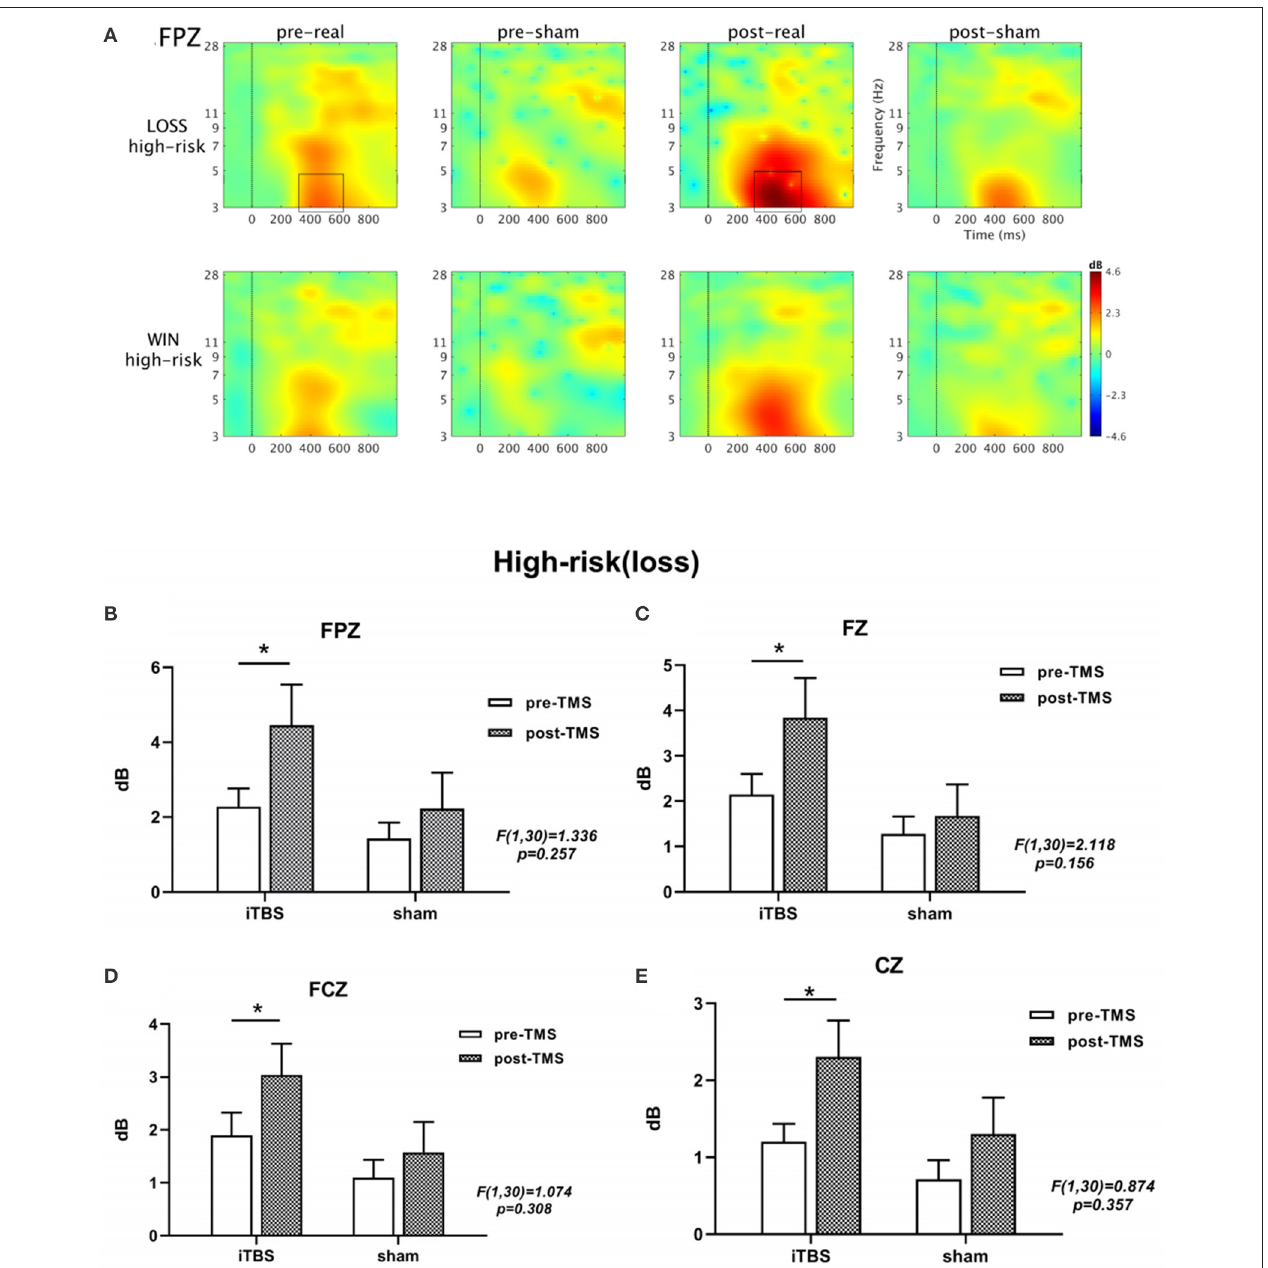
FIGURE 2 | The results obtained from the FPZ electrode is shown in (A) . A significant difference in ERSP is seen between the two conditions (winning and losing) before and after treatment under high-risk conditions based on a paired t-test. The black boxes define the time-frequency region of interest where the power increases significantly. In addition, (B-E) show the θ -band active bar graph at four locations. *** p < 0.001; ** p < 0.01; * p < 0.05; ns: p >